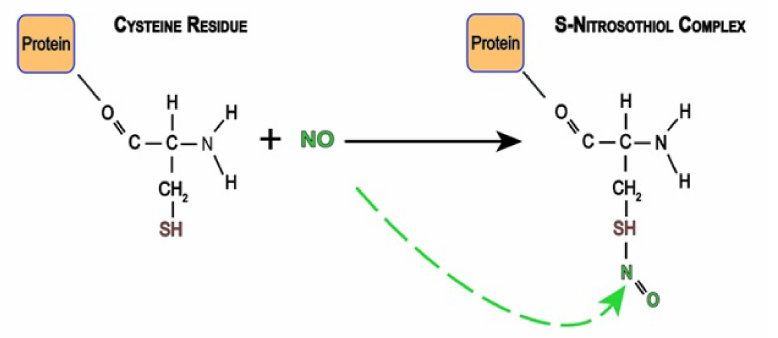
Figure 8. Reaction of nitric oxide with the cysteine sulfhydryl group. Source: